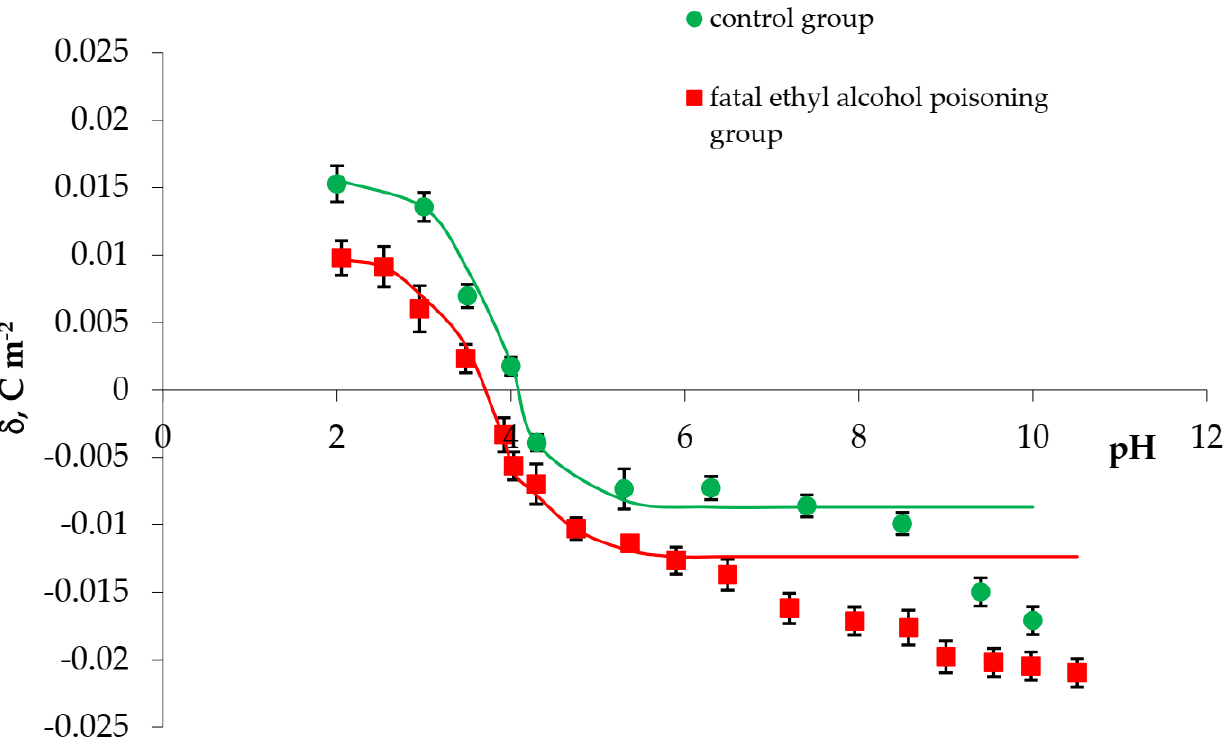
Figure 3. A comparison of experimental and theoretical surface charge density values of erythrocytes vs. pH of the electrolyte solution: • control, (cid:4) fatal ethyl alcohol poisoning. Points represent the experimental values and curves represent theoretical values.